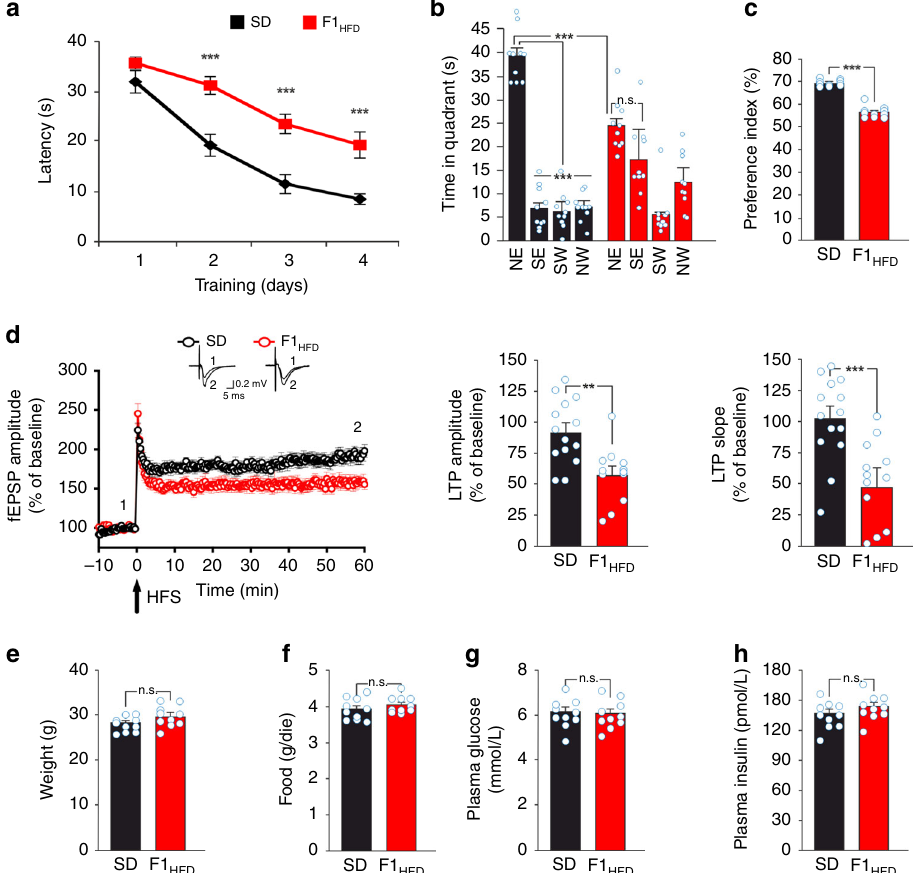
Fig. 2 Maternal HFD impairs hippocampal synaptic plasticity, learning, and memory. a Latency to reach the hidden platform in the MWM test for SD and F1 HFD mice ( n = 10 mice derived from 6 to 7 litters for each group; statistics by unpaired Student ’ s t test). b Time spent in the four quadrants during the probe test performed on day 5 of MWM. North – East (NE) is the quadrant where the platform was placed during the training (target quadrant) ( n = 10 mice derived from 6 to 7 litters for each group; statistics by unpaired Student ’ s t test for time in the target quadrant and one-way ANOVA and Bonferroni post hoc for time in all quadrants). c Preference for the novel object in the NOR paradigm ( n = 10 mice derived from 6 to 7 litters for each group; statistics by unpaired Student ’ s t test). d On the left, time course of LTP at CA3 – CA1 synapses induced by HFS delivered at time 0 (arrow) in hippocampal slices obtained from SD mice ( n = 14 slices from 5 mice of different litters) or F1 HFD ( n = 12 slices from 4 mice of different litters). Results are expressed as percentages of baseline fEPSP amplitudes ( = 100%). Insets show representative fEPSPs at baseline (1) and during the last 5 min of LTP recordings (2). Traces are averages of 5 consecutive responses at the time points indicated with 1 and 2. On the right, bar graphs showing LTP assessed by measuring fEPSP amplitudes and slopes during the last 5 min in SD and F1 HFD mice (statistics by unpaired Student ’ s t test). e Weight, f average food consumption, g fasting glucose plasma levels, and h fasting insulin plasma levels of SD and F1 HFD mice at the time point of behavioral tests ( n = 10 mice derived from 6 to 7 litters for each group; statistics by unpaired Student ’ s t test) after 2 fasting hours. Data are expressed as mean ± SEM. ** p < 0.01; *** p < 0.001; n.s.